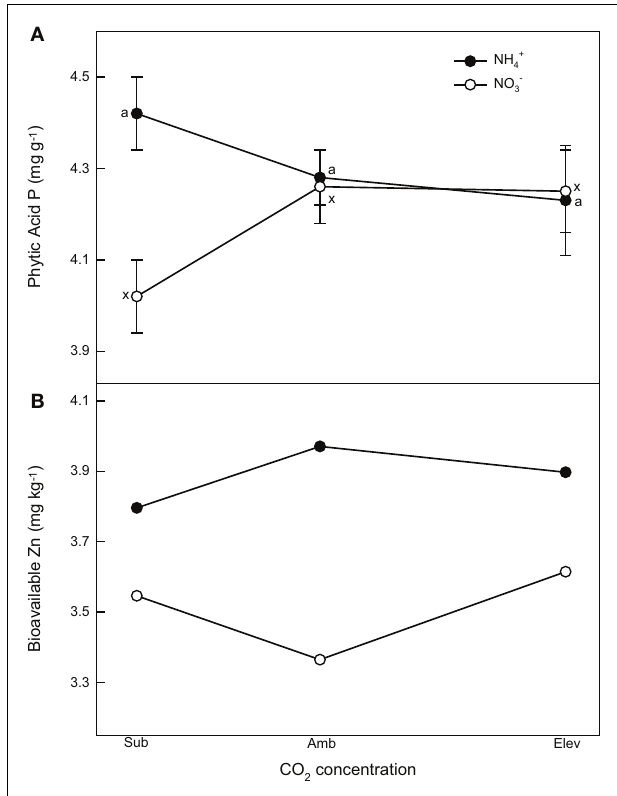
FIGURE 4 |The effect of N form and CO 2 concentration on (A) grain phytate (phytic acid) and (B) bioavailable Zn concentrations of wheat grown hydroponically to senescence. Closed (NH + symbols represent the back-transformed means and 95% confidence intervals ( n = 4).The model used to calculate the bioavailable Zn did not allow the inclusion of confidence intervals.